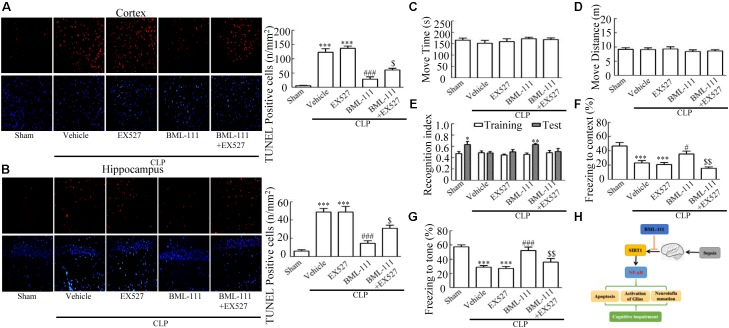
BML-111 decreases the number of TUNEL-positive cells and cognitive impairment in CLP. (A,B) The number of TUNEL-positive cells in cortex and hippocampus were significantly increased in CLP + Vehicle and CLP + EX527 mice compared with the sham group. BML-111 treatment reversed this variation in CLP + Vehicle and CLP + EX527 mice, and EX527 administration prior to CLP and BML-111 reduced these effects. Scale bars indicate 20 mm (n = 3 surviving mice per group). (E–G) EX527 treatment before CLP and BML-111 treatment decreased the recognition index for the new object when compared with the familiar one and decreased the freezing behaviors compared with the CLP + BML-111 group. (C,D) Move time and distance in the open-field-test. There was no difference among groups. (H) Schematic overview showing the involvement of BML-111 in sepsis-induced brain dysfunction. Data were shown as the means ± SEM (n = 10 survived mice in C–G). ∗P < 0.05, ∗∗P < 0.01 represent Test vs. Training in E. ∗∗∗P < 0.001 represent CLP + Vehicle vs. Sham and CLP + EX527 vs. sham in A,B,F,G, #P < 0.05, ###P < 0.001 represent CLP + BML-111 vs. CLP + Vehicle in A,B,F,G, $P < 0.05, $$P < 0.01 represent CLP + BML-111 + EX527 vs. CLP + BML-111 in A,B,F,G.